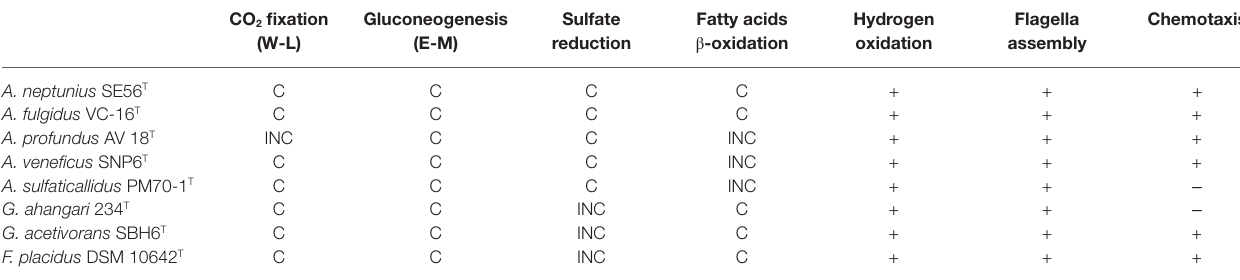
TABLE 2 | Gene sets encoding various physiological properties in genomes of type strains of Archaeoglobi . CO 2 fixation